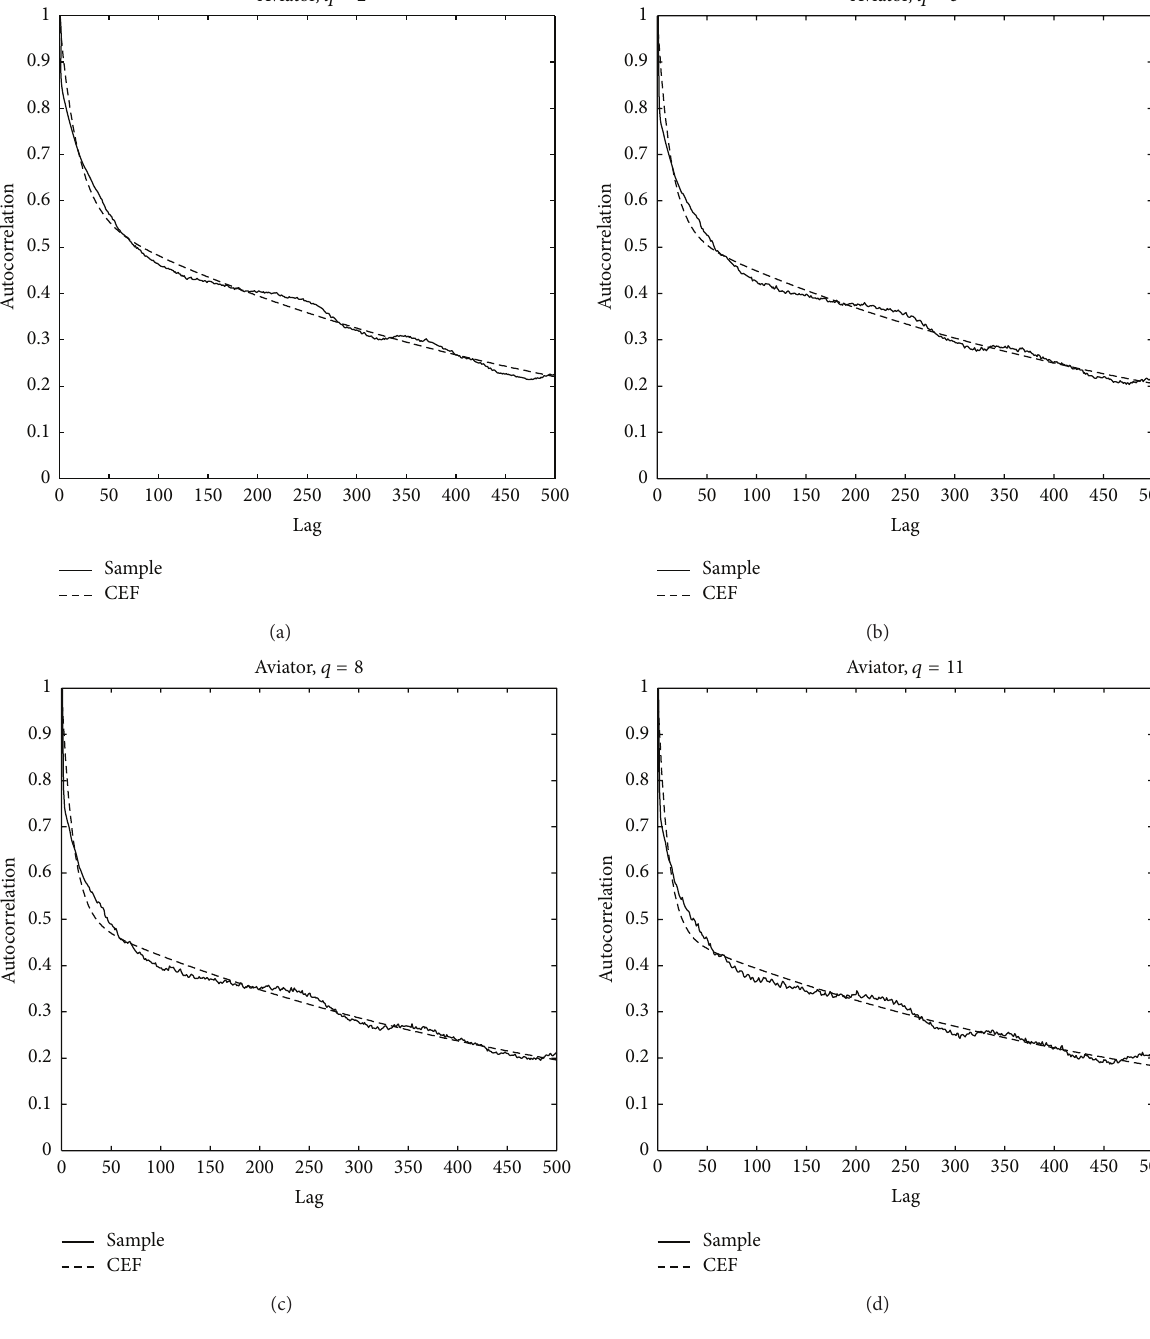
Figure 3: Autocorrelation graphs and fit for quantizer values 𝑞 = 2, 5,8 , and 11 for